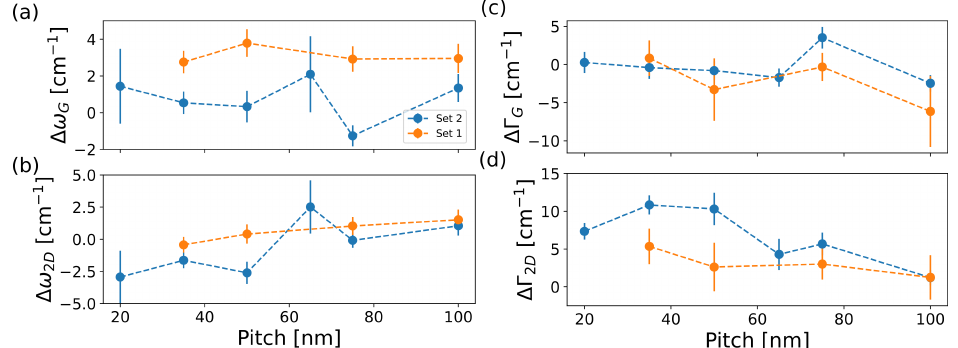
Figure 5. ( a , b ) Changes in the G and 2 D peak positions with respect to the pristine flake as a function − ω 0 of the pitch p . Here, ∆ ω G ,2 D = ω def , where ω 0 and ω def are the positions of the G and G ,2 D G ,2 D G ,2 D G ,2 D 2 D peaks before and after the irradiation, respectively. ( c , d ) Changes in the G and 2 D peak widths − Γ 0 with respect to the pristine flake as a function of the pitch p . Here, ∆Γ G ,2 D = Γ def , where G ,2 D G ,2 D Γ 0 and Γ def are the widths of the G and 2 D peaks before and after the irradiation, respectively. G ,2 D G ,2 D Standard deviations are used as error